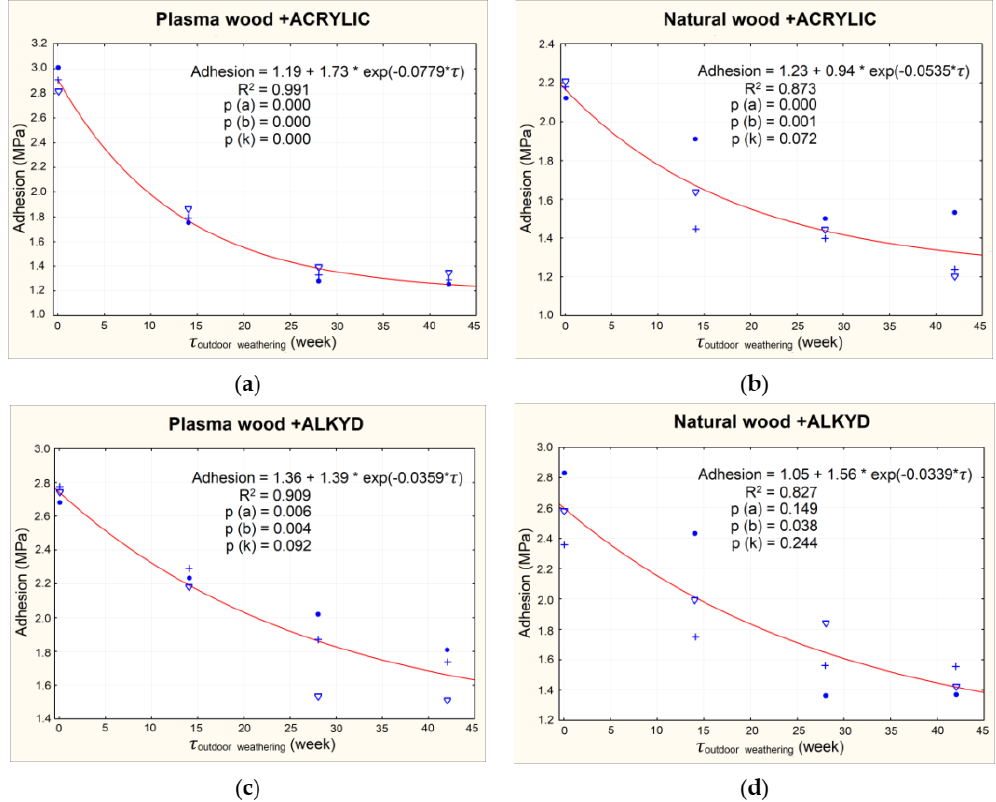
Figure 3. The summary evaluation—negative e ff ects of the outdoor weathering prolongation (from 0 to 42 weeks) on the adhesion strength between the acrylic ( a , b ) or alkyd ( c , d ) coatings and the